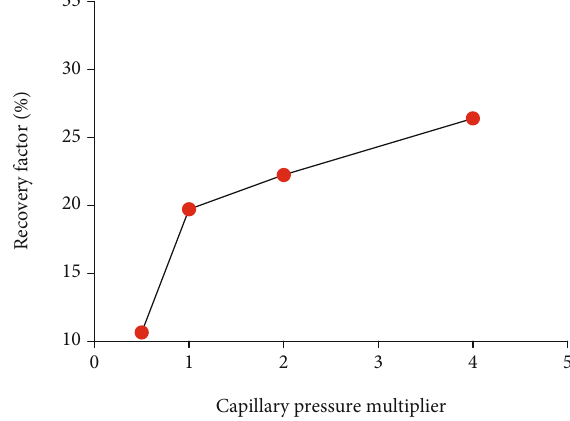
Figure 5: Production curves of reservoirs with di ff erent matrix permeabilities by cyclic surfactant injection.